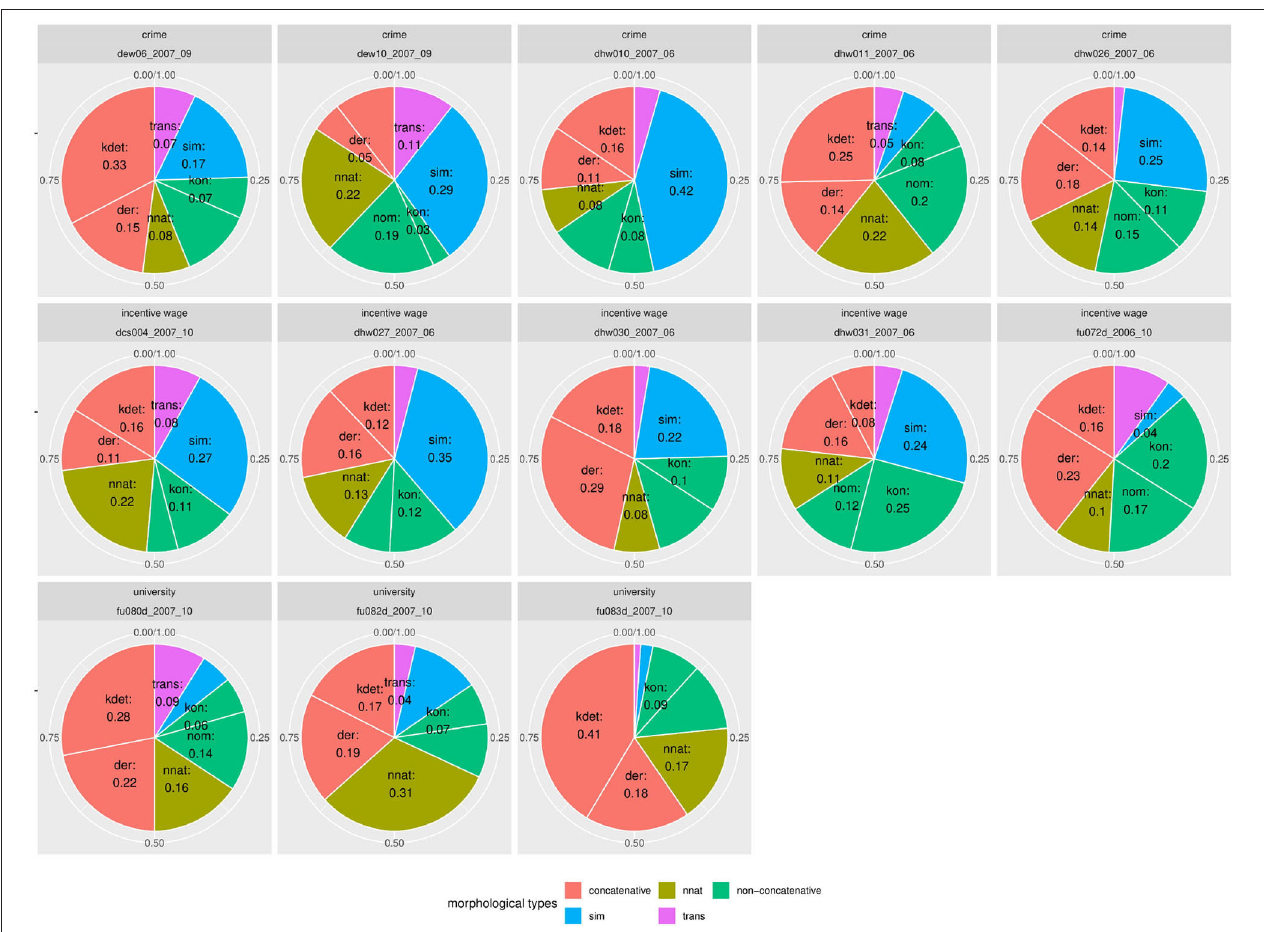
FIGURE 7 | The variety of distributions of noun types is even more striking when displayed by individual document. Even documents pertaining to the same topic vary